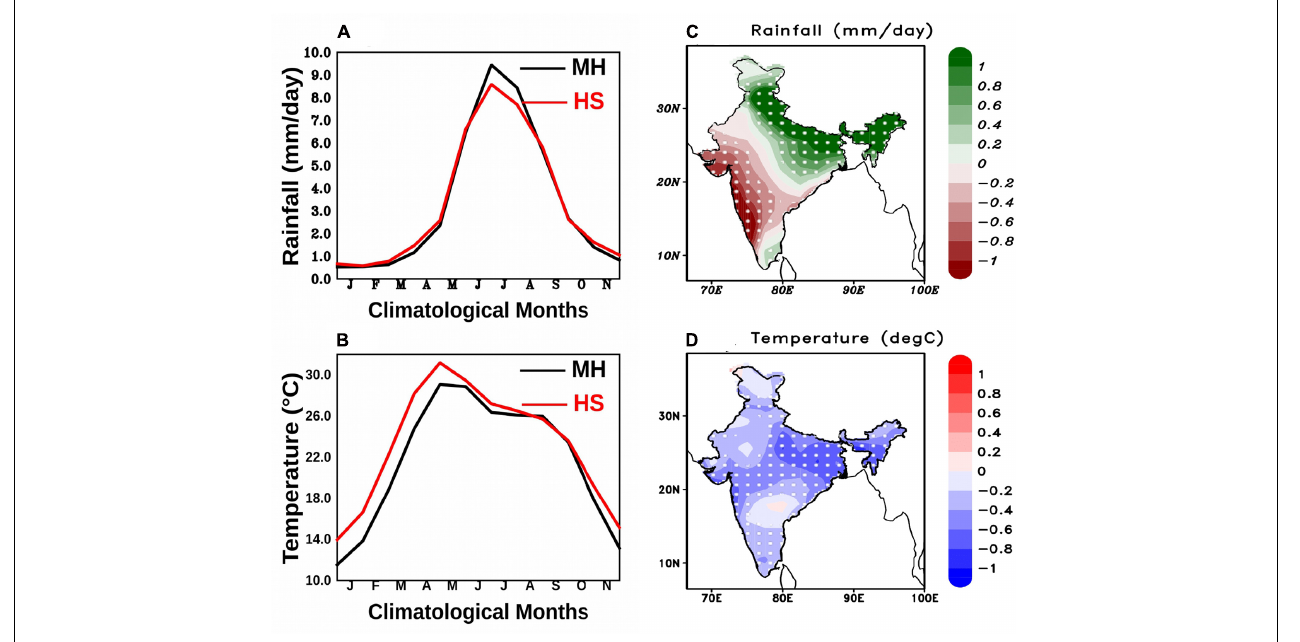
FIGURE 2 | Comparison between the area-averaged seasonal cycle of Mid-Holocene (MH) and Historical period, (A) is for the simulated rainfall and (B) is for the simulated surface temperature over Indian land region. Spatial distributions of the simulated summer monsoon rainfall (mm/day; C ) and surface temperature ( ◦ C; D ) for MH with the difference to HS. The dotted region represents a statistically significant region at a 95% confidence level from a two-tailed Student’s t -test.